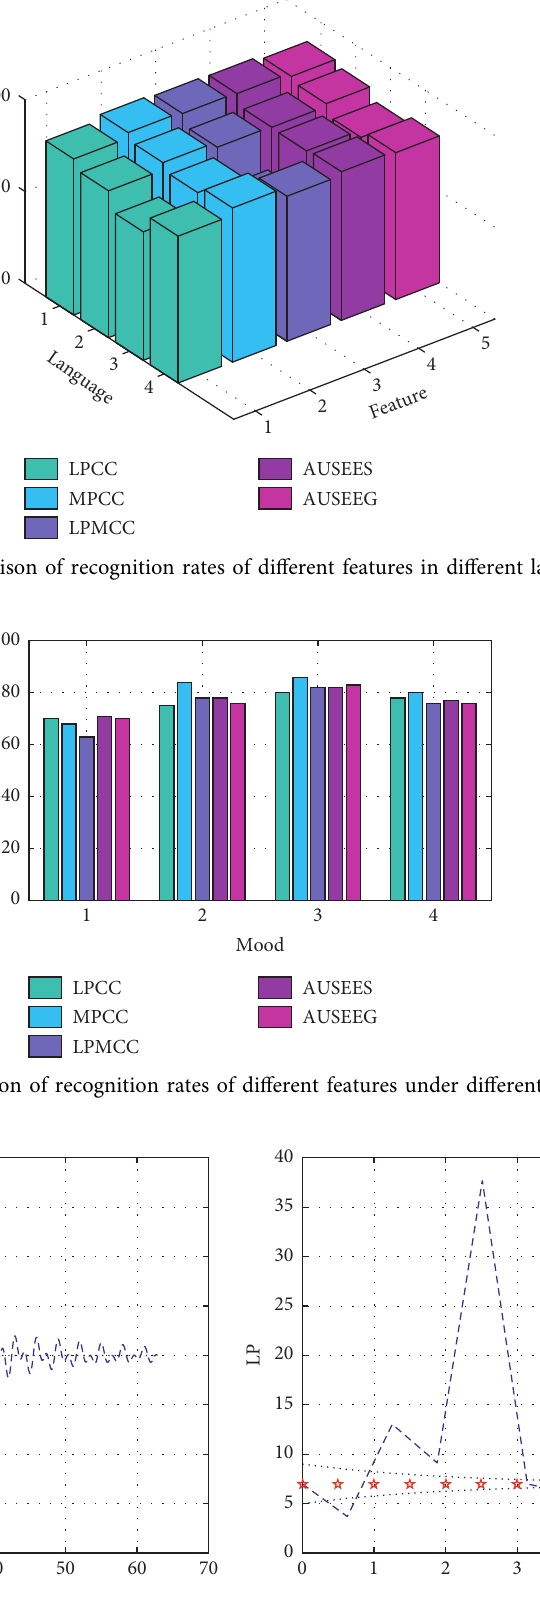
, λ values on the results: (a) the left is LR and (b) the right is the LP change 1 2